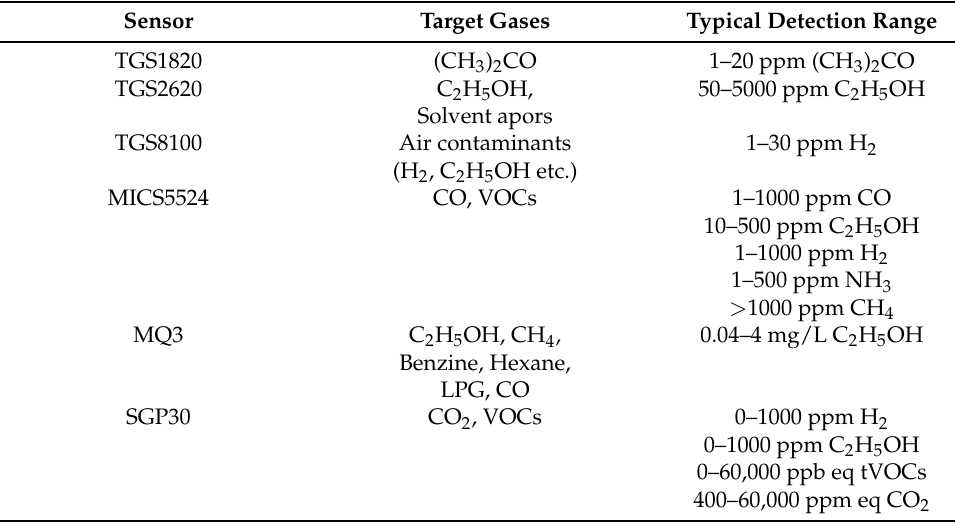
Figure 3. Scheme of the proposed measurement system. Table 3. Sensors used in